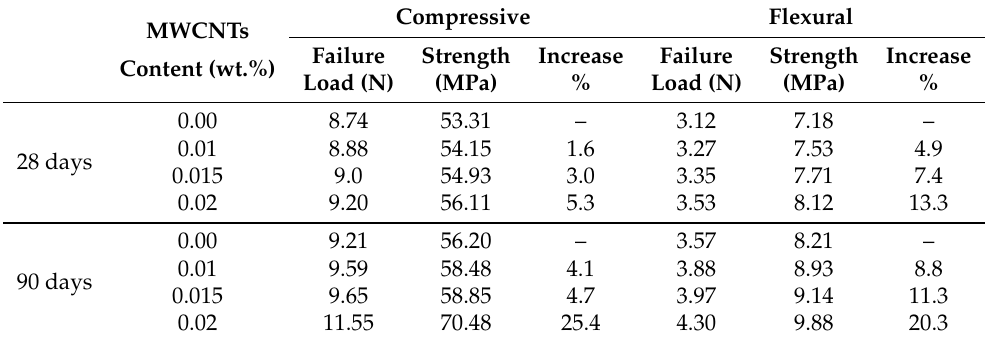
Table 5. Compressive and flexural loads and strength.